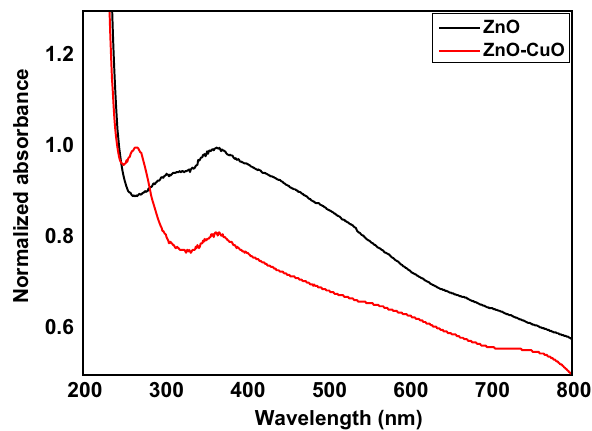
Fig. 1 UV–visible spectra of aqueous dispersions of ZnO ( black line ) and ZnO–CuO NMs ( red line )